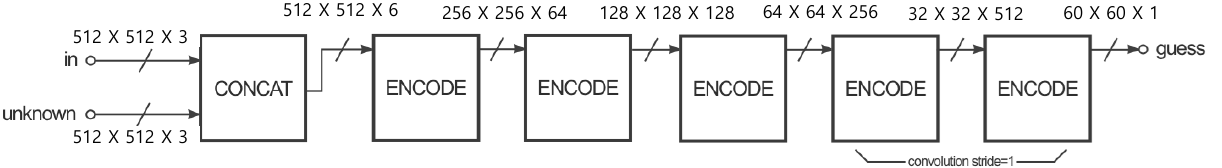
Figure 9. The structure of the discriminator.